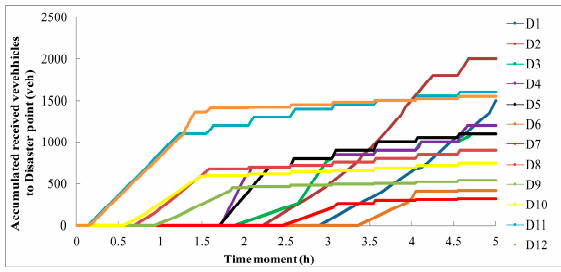
Figure 12. The accumulated received materials of each disaster point considering dynamic material demand.